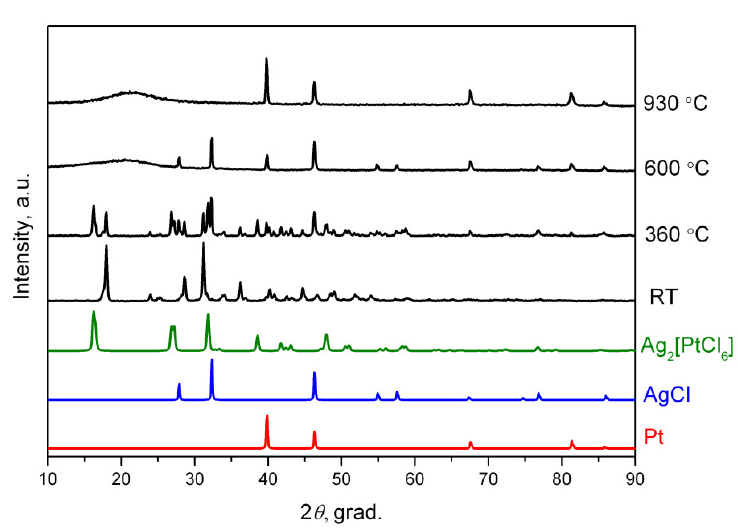
Figure 3. Diffraction patterns of Ag 2 [PtCl 4 ] and its thermolysis products in a helium atmosphere at different temperatures. RT- room temperature.